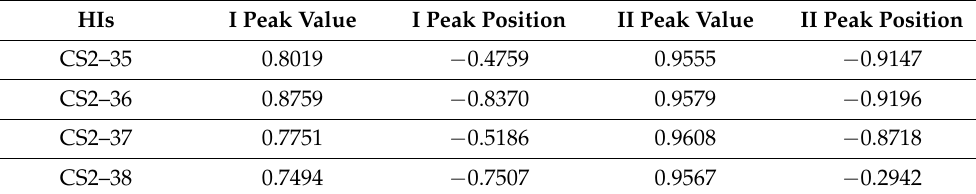
Table 2. Results of Pearson correlation coefficient calculation for 4 groups of